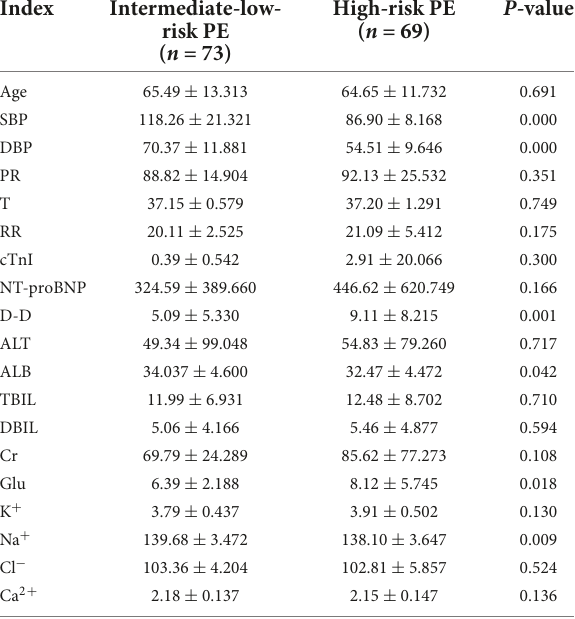
TABLE 3 General data and serum biomarkers in intermediate-low-risk PE patients and high-risk PE